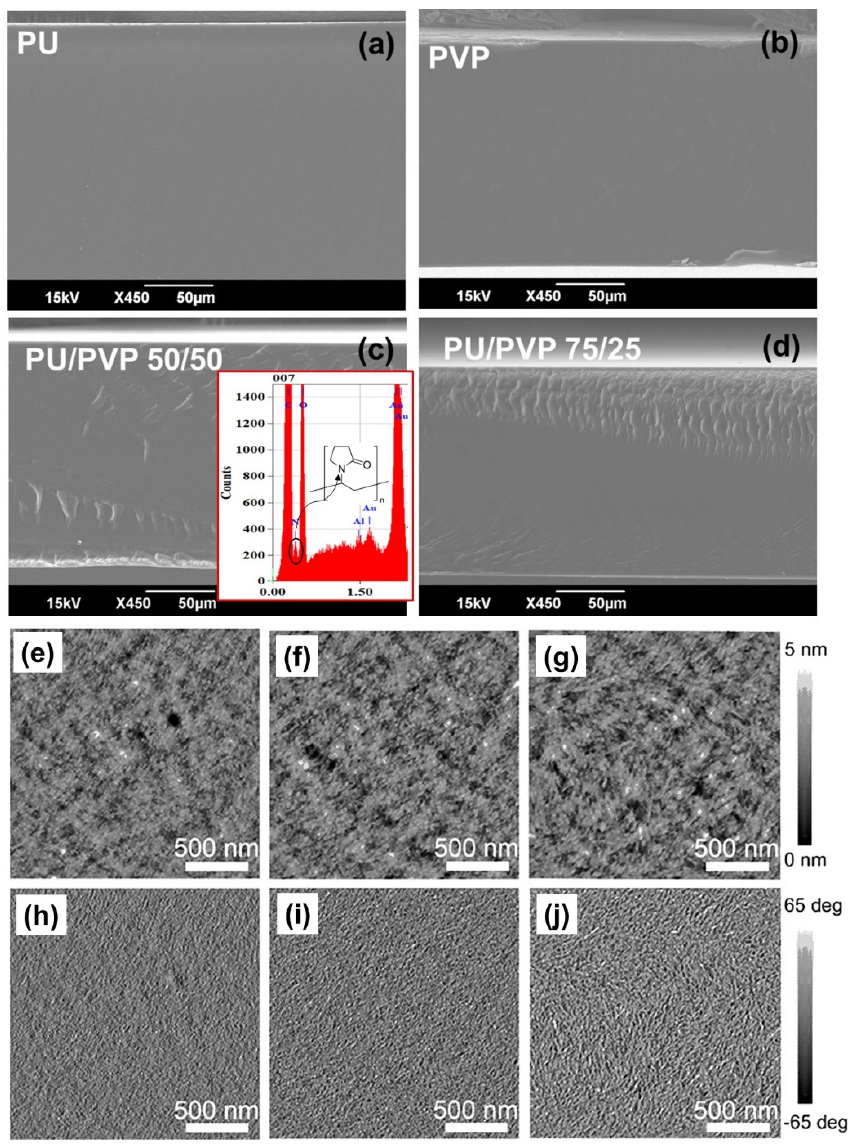
Figure 2. SEM cross section images of ( a ) pure PU film, ( b ) pure PVP film, ( c ) PU/PVP_50/50 hybrid film and ( d ) PU/PVP_75/25 hybrid. AFM height and phase images for PU/PVP_90/10 ( e , h ), PU/PVP_75/25 ( f , i ) and PU/PVP_50/50 ( g , j ).